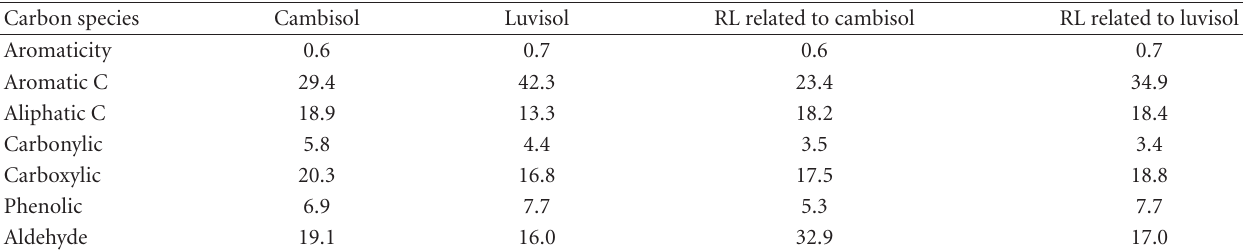
Table 4: Carbon species of humic acids on the base of 13-NMR spectra, Percentage of each carbon species to carbon in